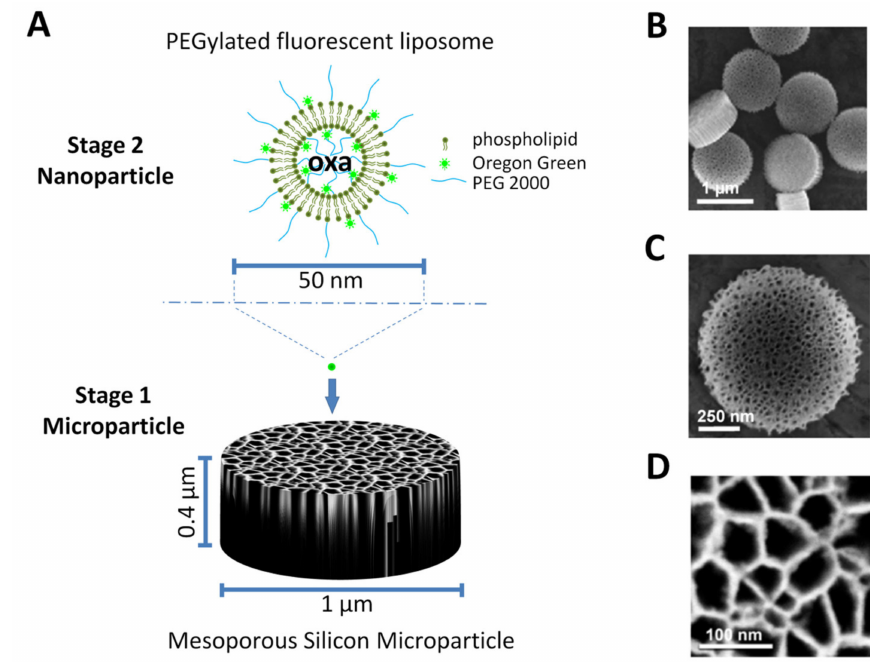
Figure 1. Mesoporous silicon microparticles (MSMP) and multistage vector (MSV). ( A ) Scheme of MSVs, showing the geometry and size of the MSMPs and liposomes; ( B – D ) scanning electron micrographs showing discoidal-shaped MSMPs 1 µ m in diameter, 0.4 µ m thick and with 60 nm pores; ( B , C )